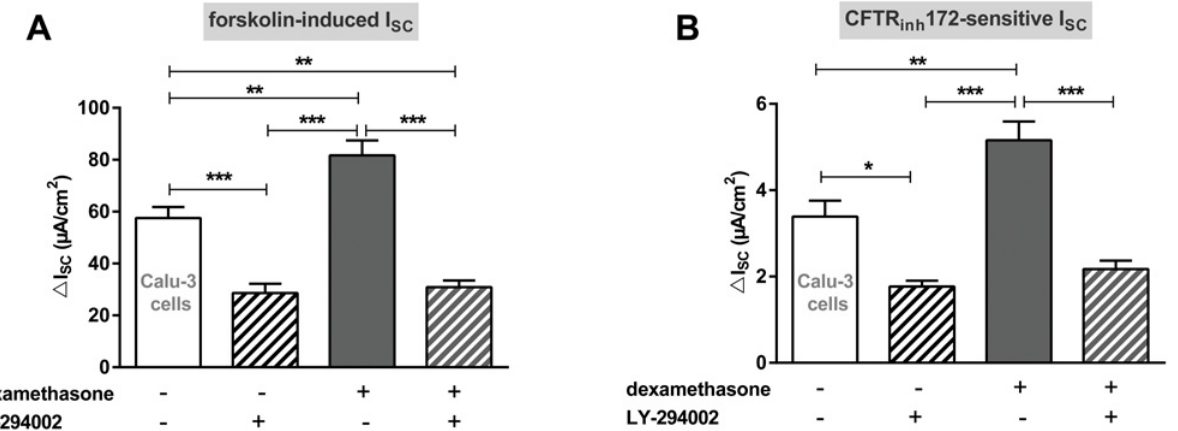
Fig 8. LY-294002 prevents the increase of CFTR activity induced by dexamethasone in Calu-3 cells. Graphs represent the mean + SEM of I SC in response to 100 nM dexamethasone and LY-294002 for 24 h measured in Ussing chambers. A: Forskolin-induced I SC (n = 12 – 18, ** p < 0.01, *** p < 0.001, ANOVA with Tukey's post hoc test). B: CFTR inh 172-sensitive I SC (n = 12 – 18, * p < 0.05, ** p < 0.01, *** p < 0.001, ANOVA with Tukey's post hoc